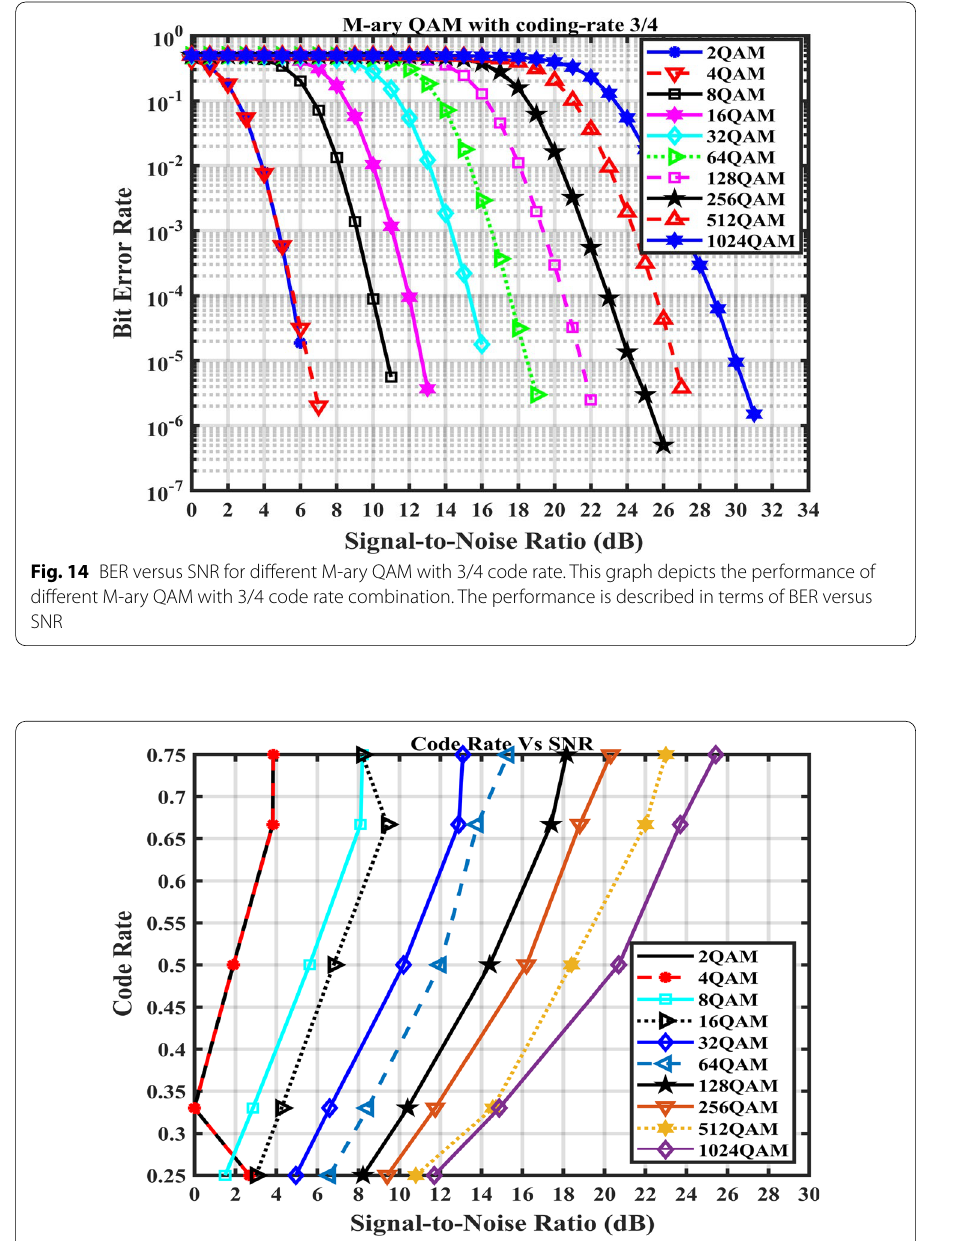
Fig. 15 Code rate versus SNR for different modulation schemes for target bit error rate of 10 − 2 . In this graph the effect of channel coding at a desired BER of 10 − 2 is presented by showing the performance of different M-ary QAM scheme with respect to code rate of 1/4, 1/3, 1/2, 2/3, and. 3/4 over a range of SNR